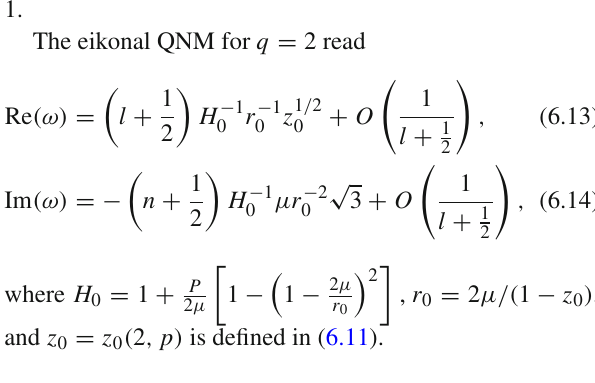
√ Z ( p ) ∼ p − 3 / 2 ( 1 − p + O ( p )) as p → + 0 and Z ( p ) ∼ 2 − 1 p − 2 as p → +∞ which imply z 0 ( 2 , p ) → 1 / 3 as p → ( 2 , p ) → 1 as p → +∞ . It may be verified that + 0 and z 0 the function z 0 ( 2 , p ) is monotonically inreasing from 1 / 3 to